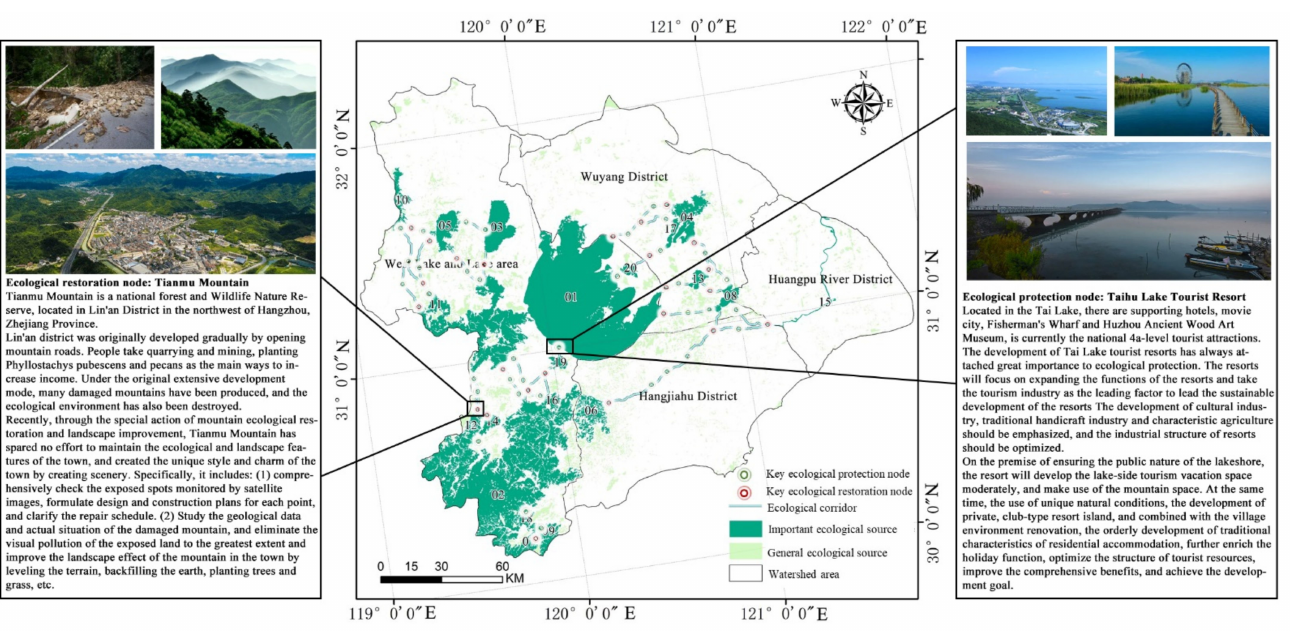
Figure 9. Two key nodes of ecological protection and restoration around the Taihu Lake